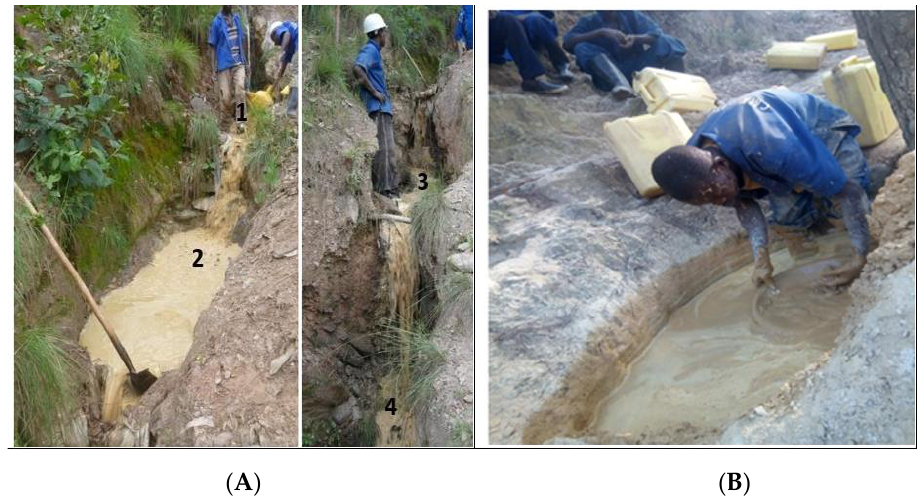
Figure 2. The general ground sluicing method ( A ) [1] and panning method ( B ) of Company X.